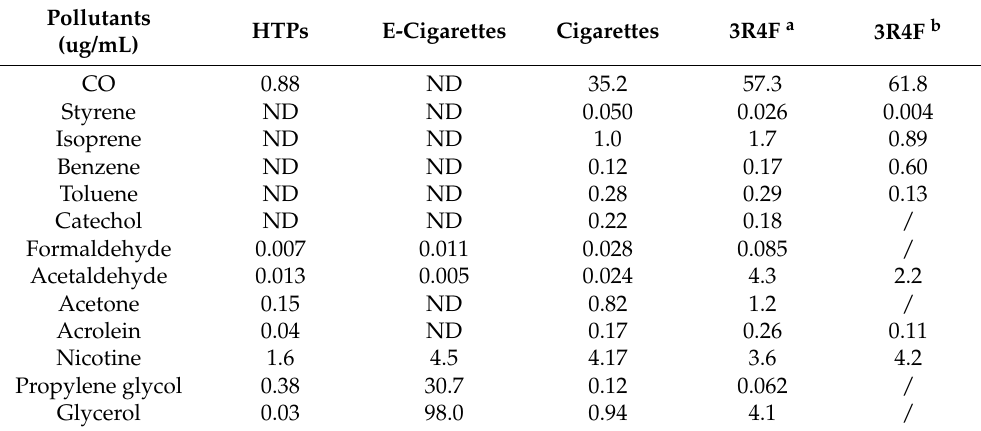
Table 1. The concentration of common pollutants released from different types of tobacco products and